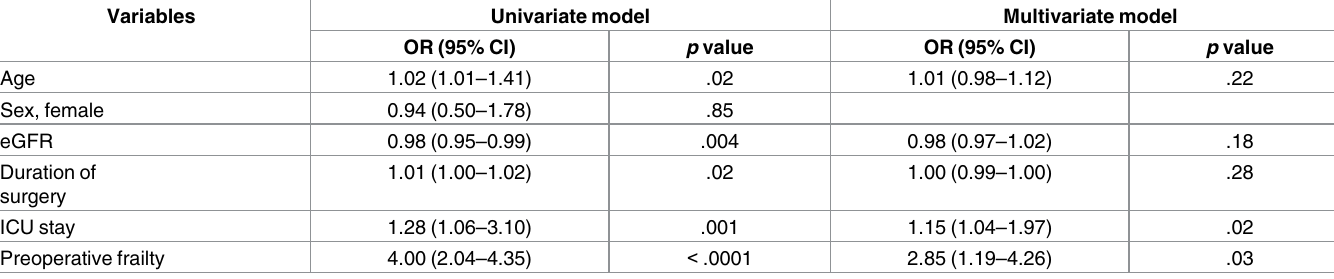
Table 3. Univariate and multivariate analysis of risk factors for development of postoperative delirium.